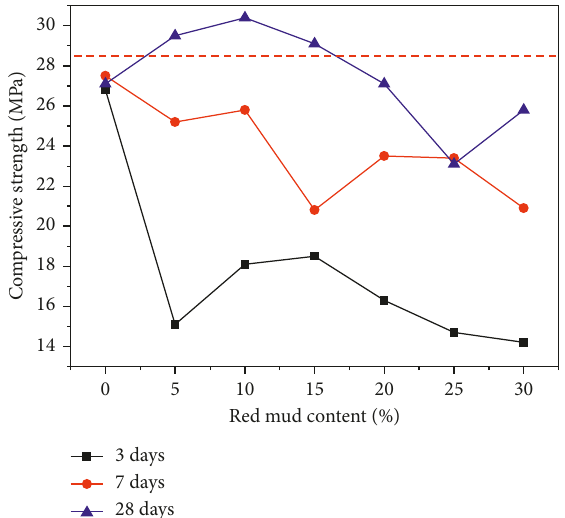
Figure 4: Compressive strength of concrete (3, 7, and 28 days of curing) as a function of substituting RMC for cement (for 25%